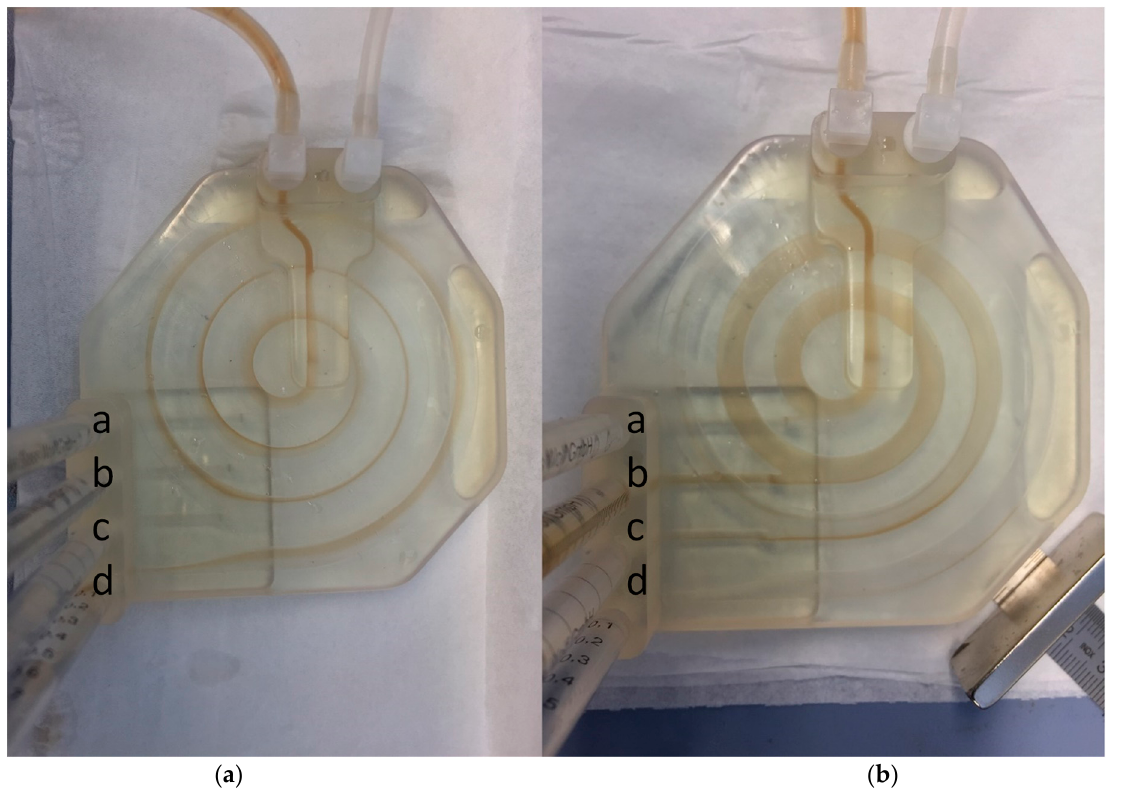
Figure 6. Separation of bare MNPs at pH 9 without ( a ) and with ( b ) magnet.